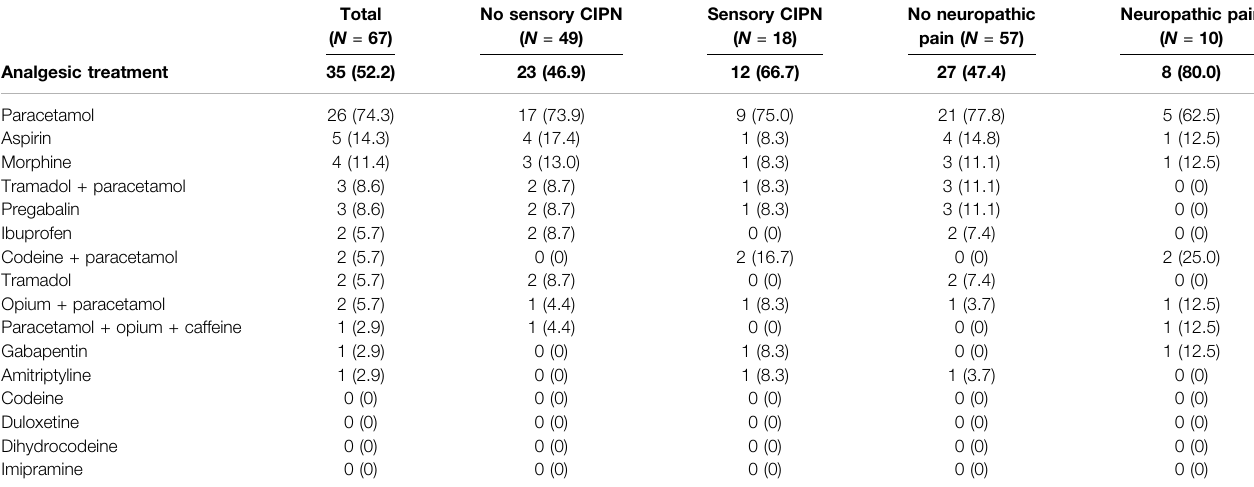
TABLE 3| Ongoinganalgesictreatmentsamongallthepatientsincluded,patientswithoutorwithasensoryCIPNandpatientswithoutorwithneuropathic pain.Categorical variables are expressed as numbers (%).